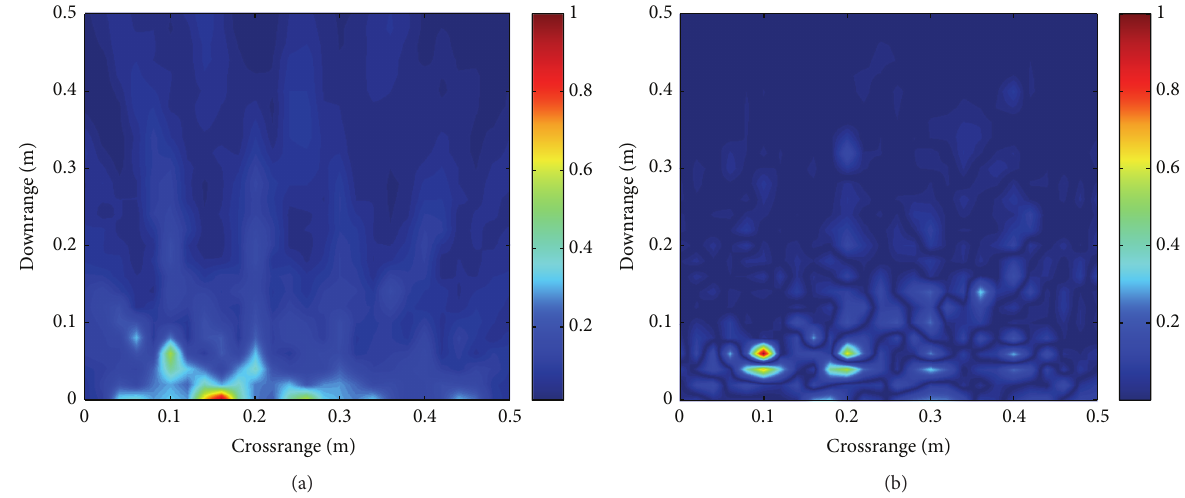
Figure 4: Imaging result (a) obtained by using the conventional TRI and (b) obtained by using signal amplitudes at 𝑡 focus .